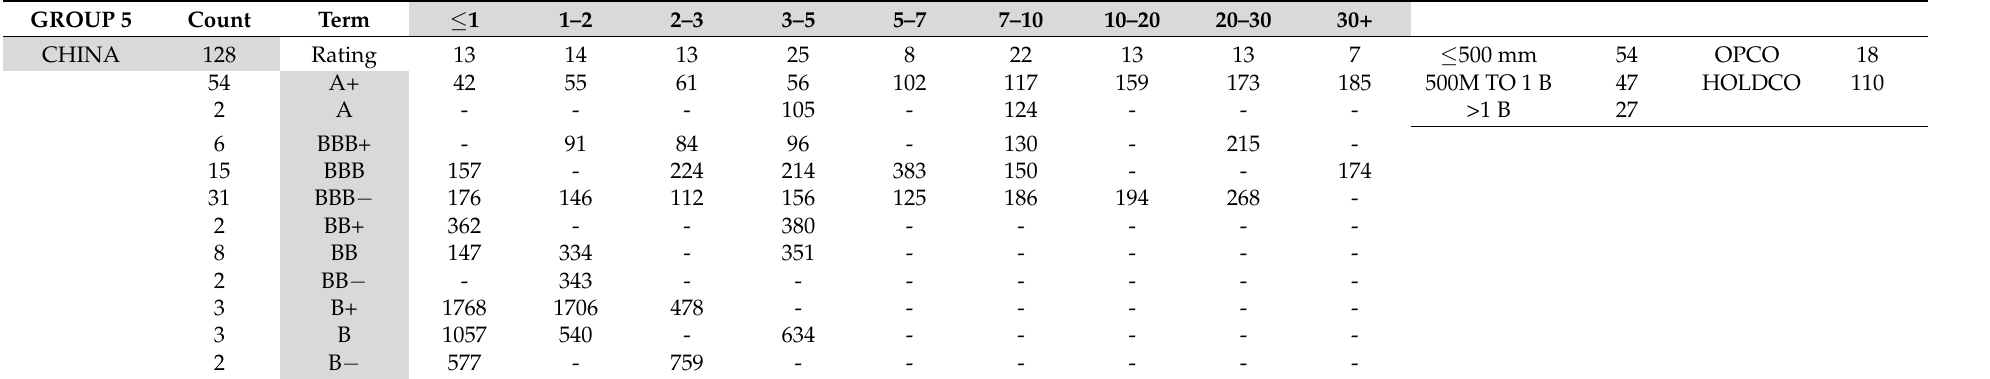
Table 7. G20—Group 5—Corporate credit spreads with S&P ratings and terms to maturity, issue amount, and the business structure of the issuer. Adding